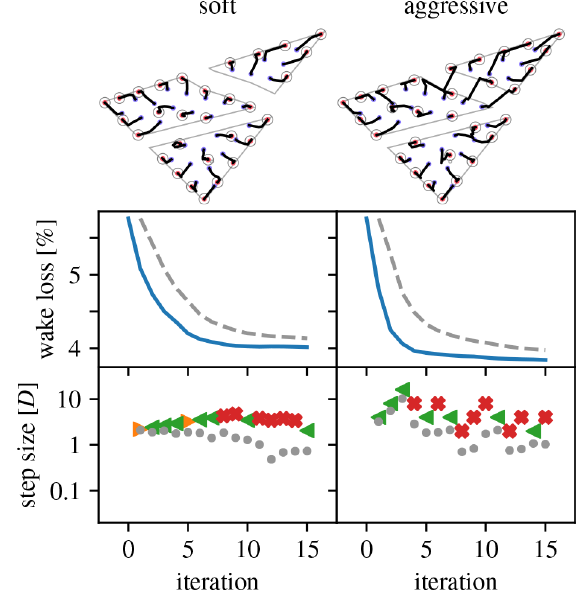
Figure 19. Overview of optimization runs for the Borssele IV wind farm layout problem, 30-turbine case. (Legend in Table 1.)